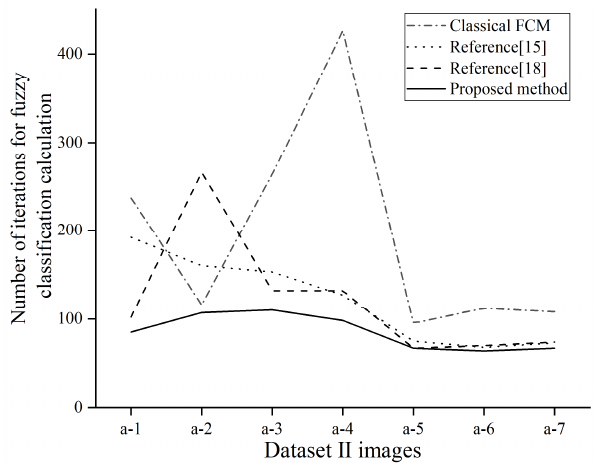
Figure 12. Number of iterations of eye image segmentation.